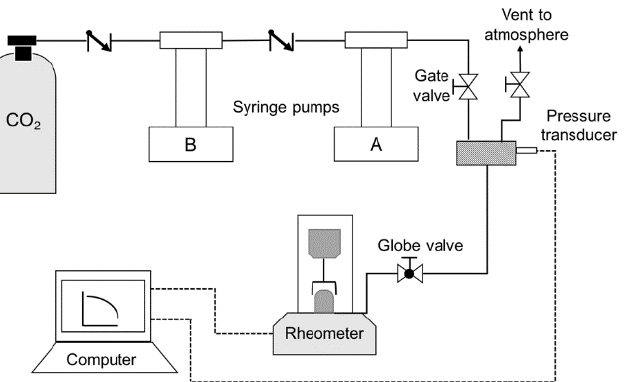
Figure 1. Schematic of the experimental setup: two syringe pumps used to pressurize with CO 2 the cell of the rheometer already sealed and loaded with a PS sample.